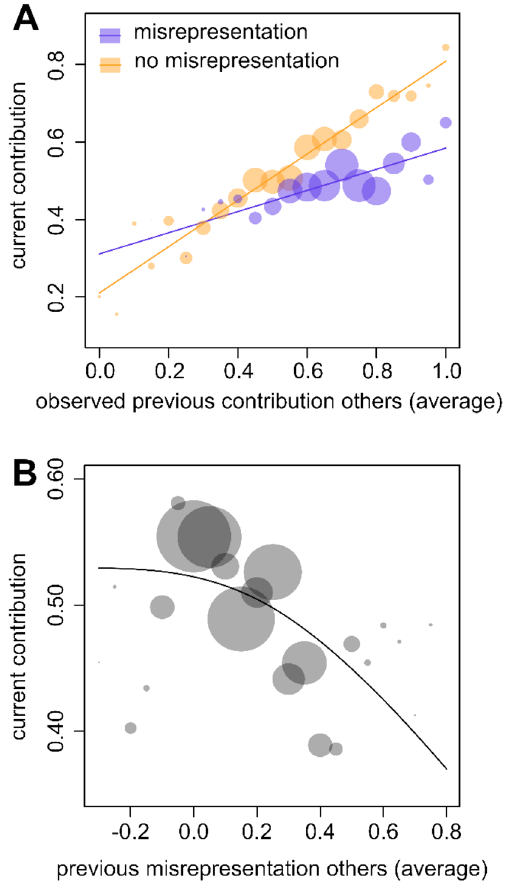
Figure 3. Misrepresentation undermines cooperation by weakening conditional cooperation and eliciting lower contributions. ( A ) If misrepresentation was possible, individuals were less responsive to the contributions of the other group members than in the absence of misrepresentation opportunities. Circles indicate how much individuals contributed on average depending on the average observed previous contribution of their fellow group members (i.e. stated contributions in case of the misrepresentation treatments). The radius of the circles indicate number of observations. The lines are given by a simple linear regression that included only misrepresentation, the previous average contribution of the fellow group members, and their interaction as predictors. ( B ) Increasing misrepresentation of fellow group members in the previous round led to decreasing contributions. The circles indicate the average contribution made depending on the average degree of misrepresentation of the other group members in the previous round. The radius of the circles indicate number of observations. The line is given by a simple linear regression that included only a natural cubic spline with two degrees of freedom in function of the previous average misrepresentation of the fellow group members as a predictor (this is consistent with how this variable was modelled in our overall statistical analysis, see “Methods”). Negative values indicate cases where individuals underrepresented their contributions, whereas positive values indicate